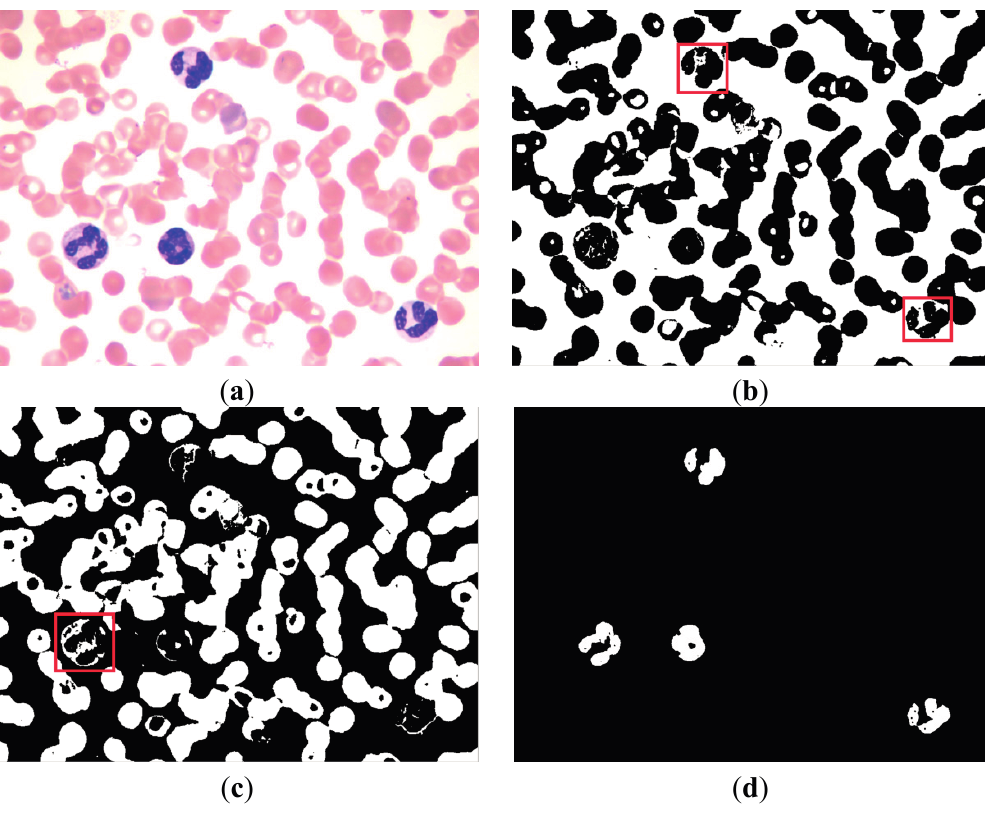
Figure 4. ( a ) Original image; ( b – d ) Partition results after clustering.